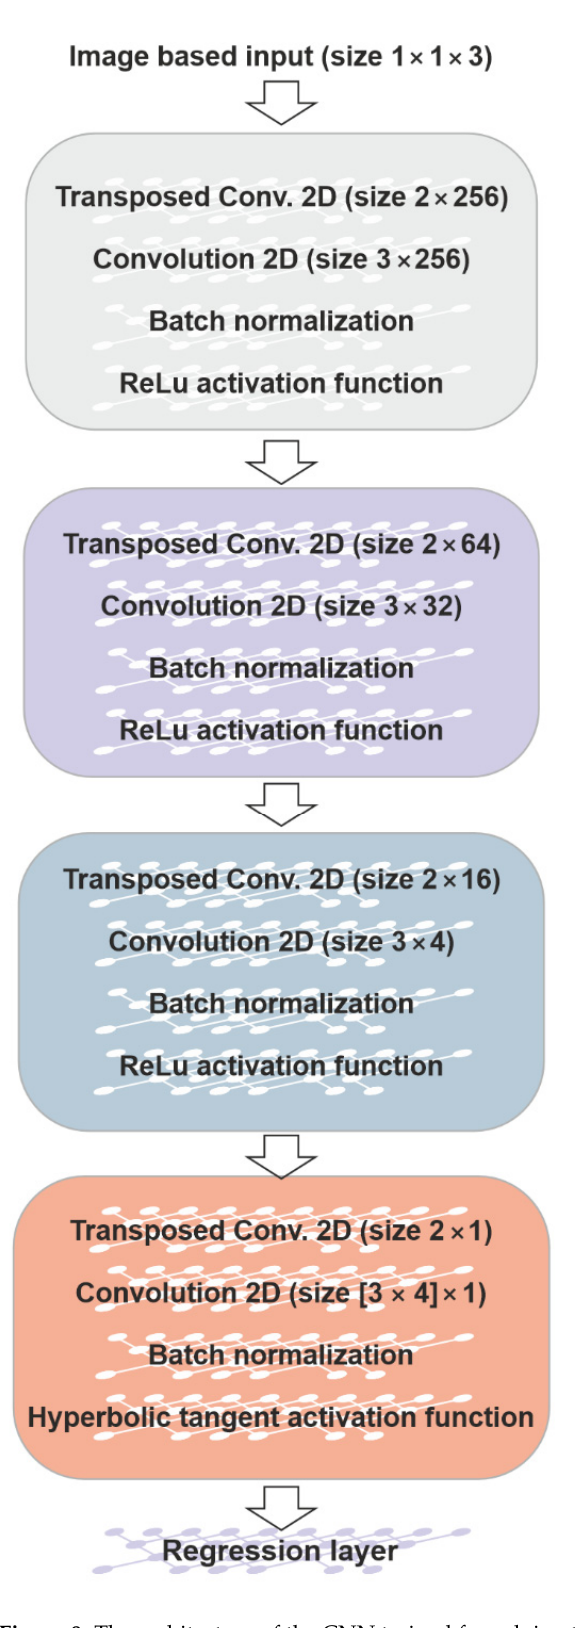
Figure 8. The architecture of the CNN trained for solving the reduced forward problem.